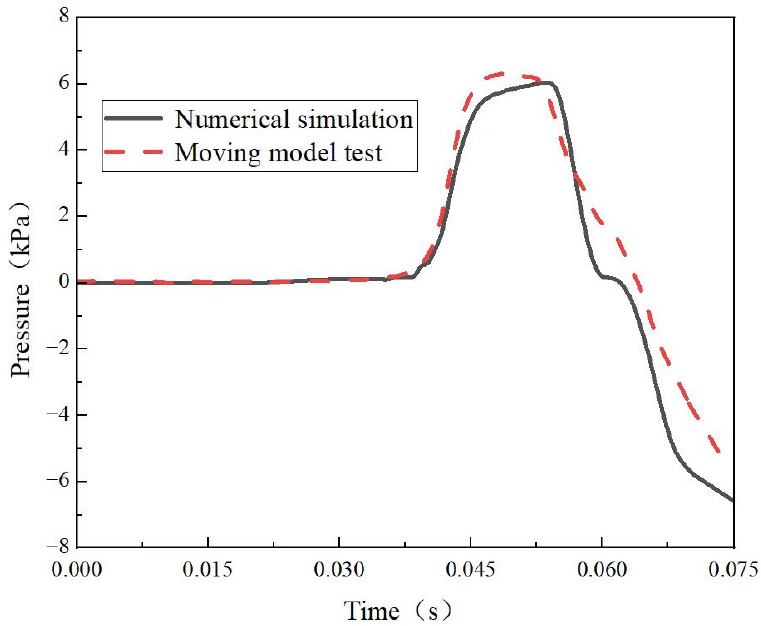
Figure 8. Comparison of dynamic model test and numerical simulation time travel curve.